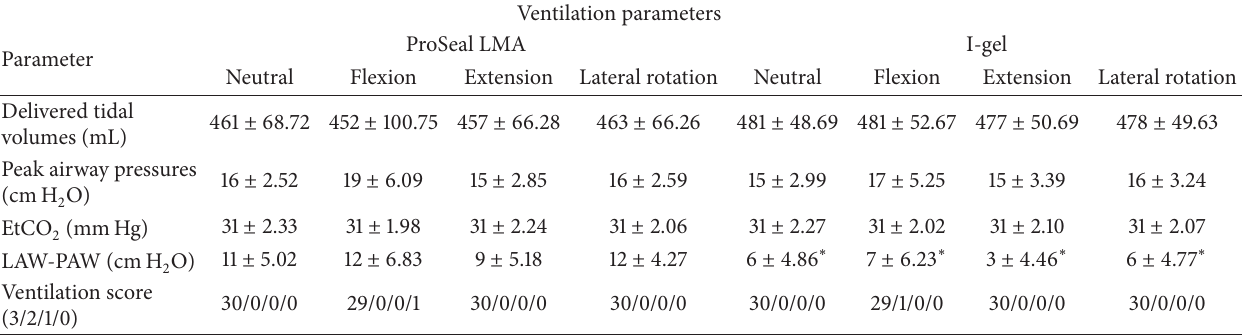
Table 8: Ventilation parameters, airway parameters, and Brimacombe scores of the